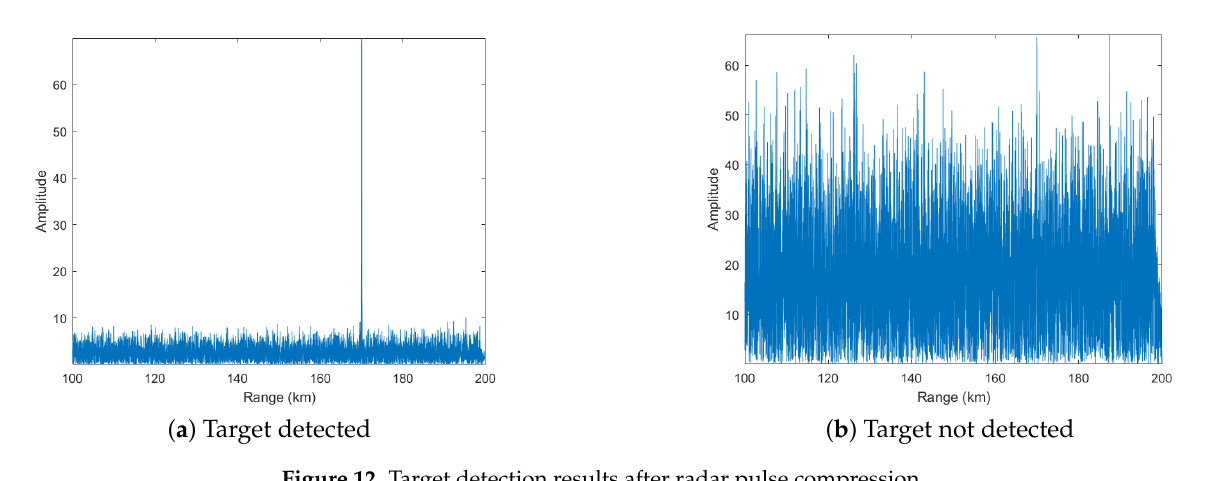
Figure 12. Target detection results after radar pulse